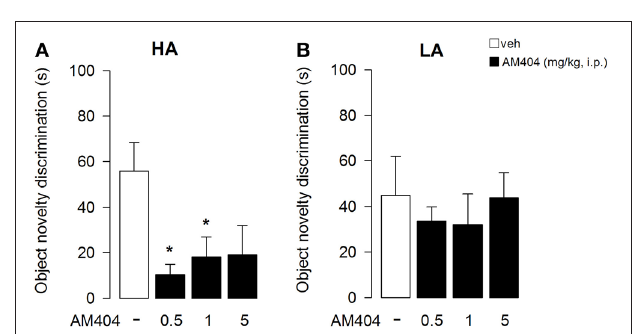
FIGURE 8 | Effects of AM404 administration on object novelty discrimination in rats exposed to high arousal (HA) or low arousal (LA) conditions. Object novelty discrimination index of rats exposed to HA (A) or LA (B) conditions. Time spent in contact with Substituted Object (SO, unfamiliar) and Non-Substituted Objects (NSO, familiar) in session 6 minus the mean time spent with objects located in the corresponding position in session 5. A discrimination index was obtained by subtracting the NSO value to SO value. * P < 0 . 05. Data are expressed as mean ± SEM.